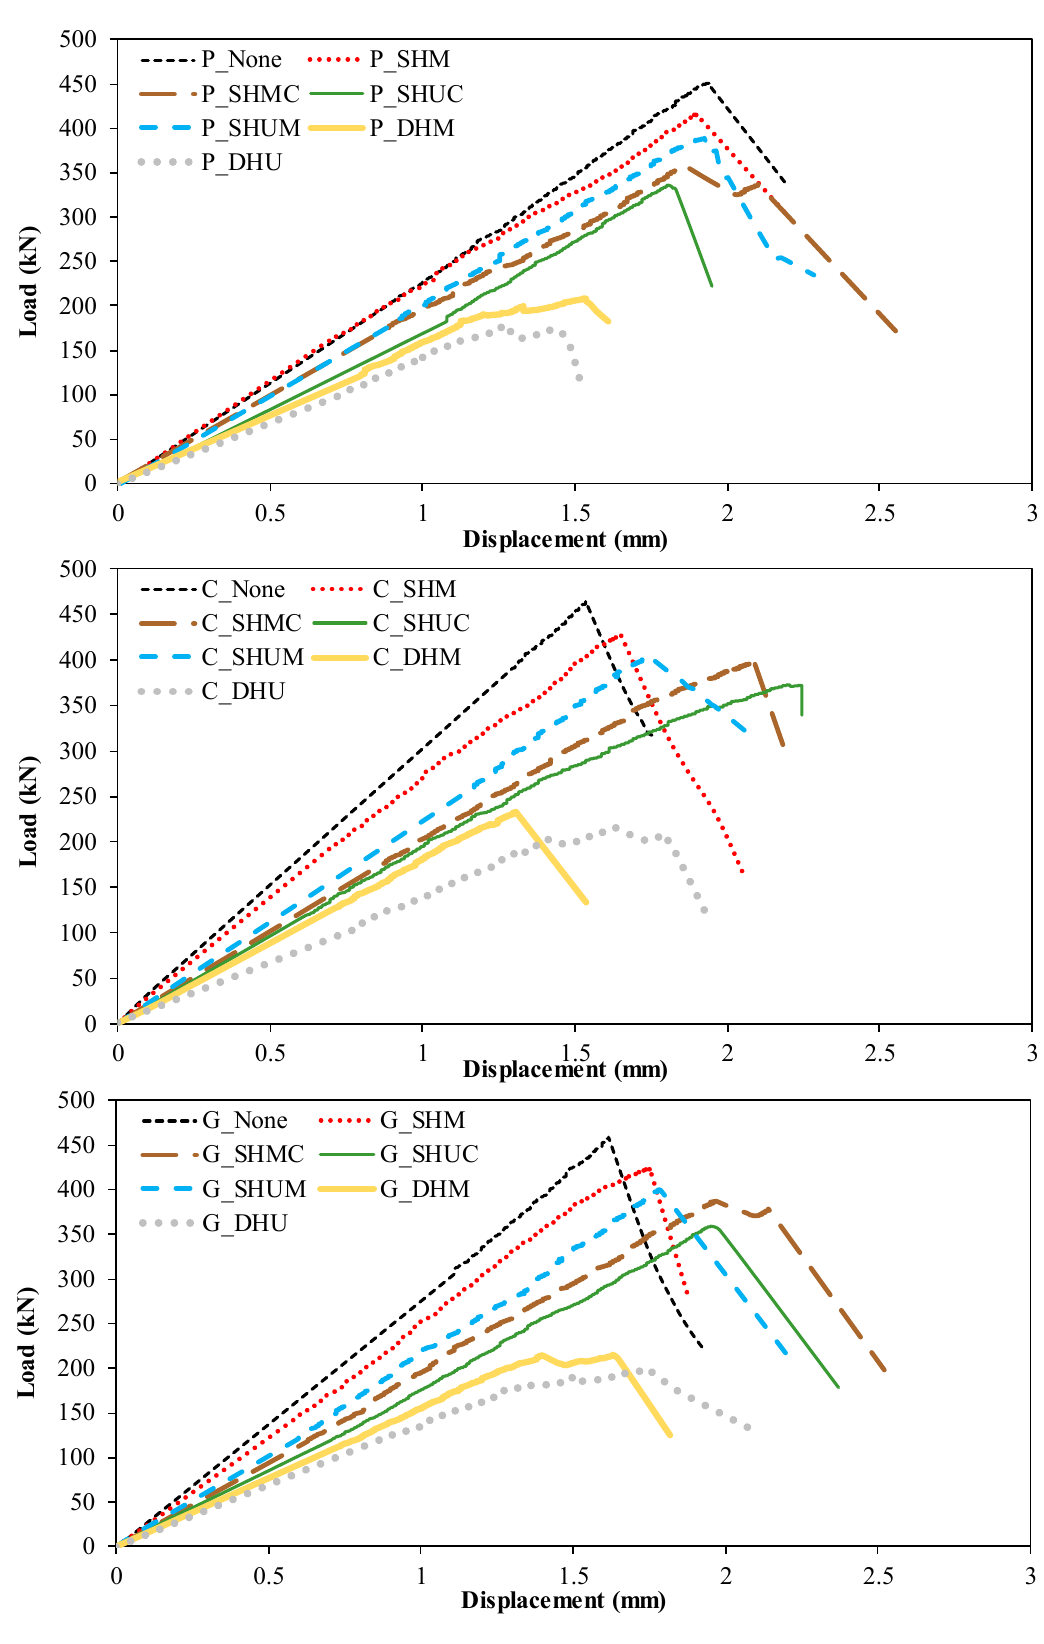
Figure 10. Load–displacement curves of openings with different locations and numbers.